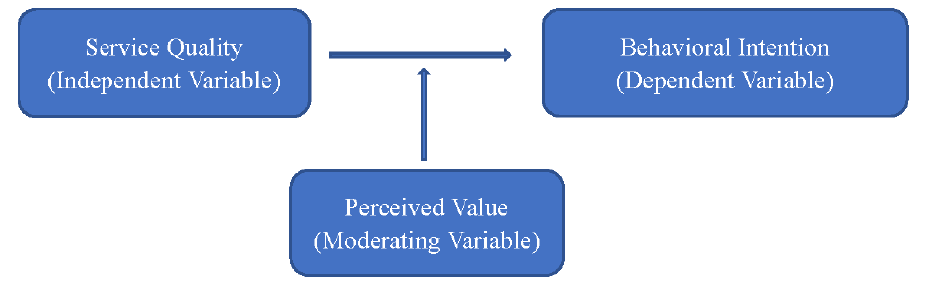
Figure 1. Theoretical framework.